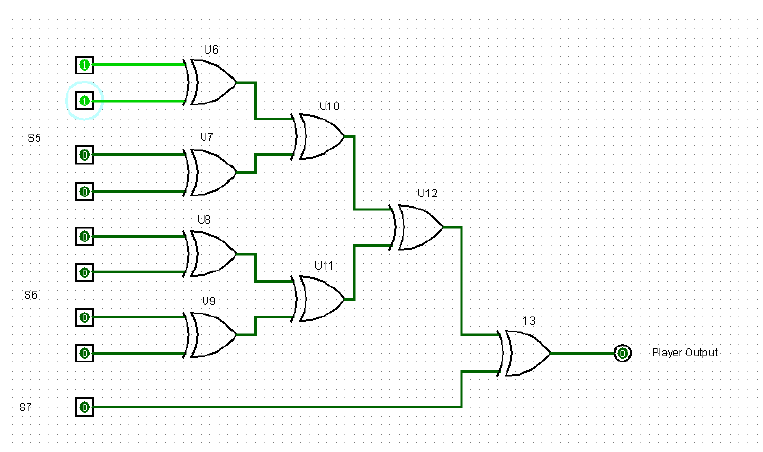
Figure A2. Player circuit